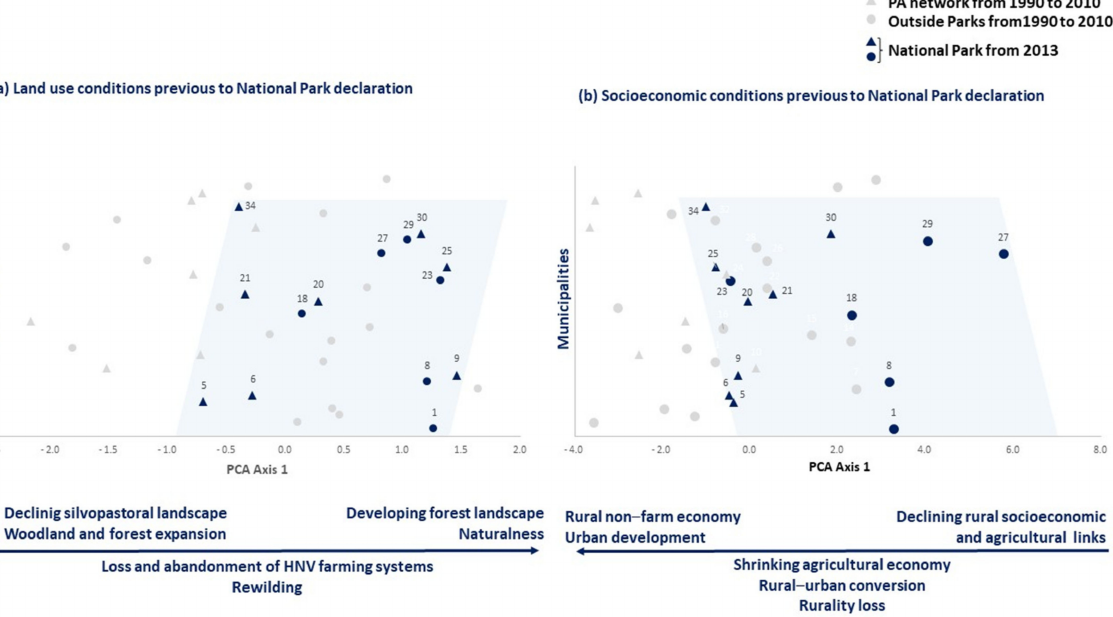
Figure 7. Social-ecological characteristics of the study territory prior to the establishment of the National Park (from the results represented in Figures 3 and 5). The blue-shaded area highlights the municipalities included inside the boundaries of the National Park. ( a ) Land use conditions; ( b ) socioeconomic